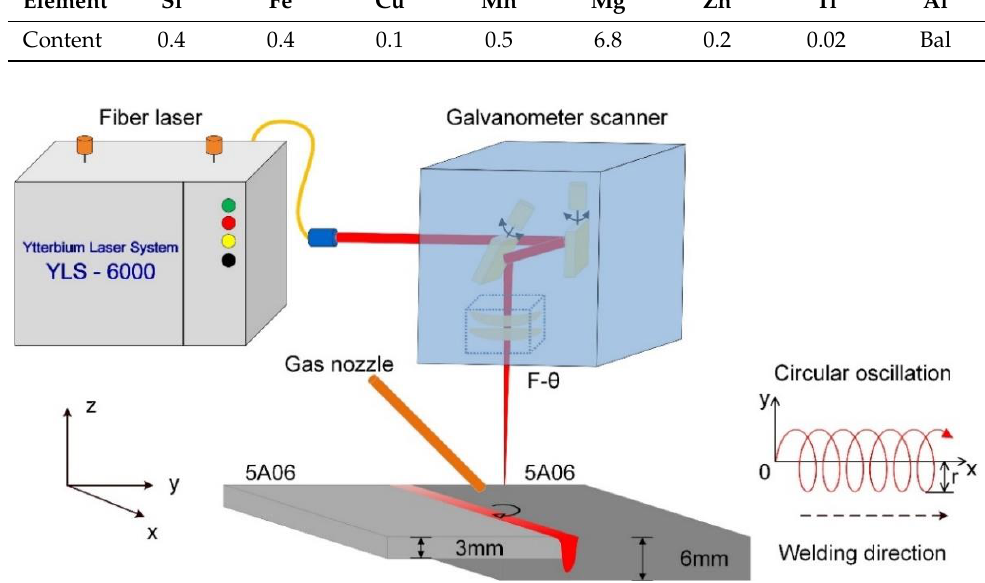
Table 1. Chemical composition (wt.%) of 5A06 Al alloy [27]. Element